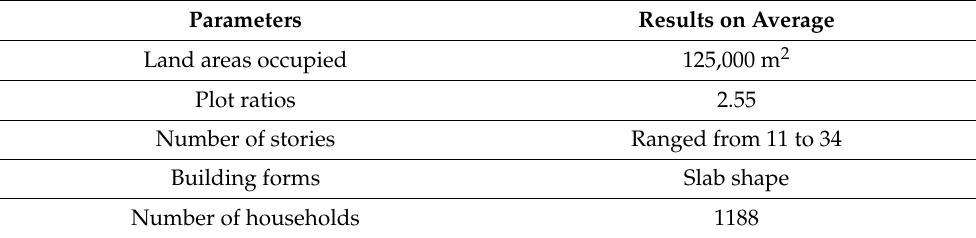
Table 2. HRCs investigated in the center areas of Qingdao. Parameters